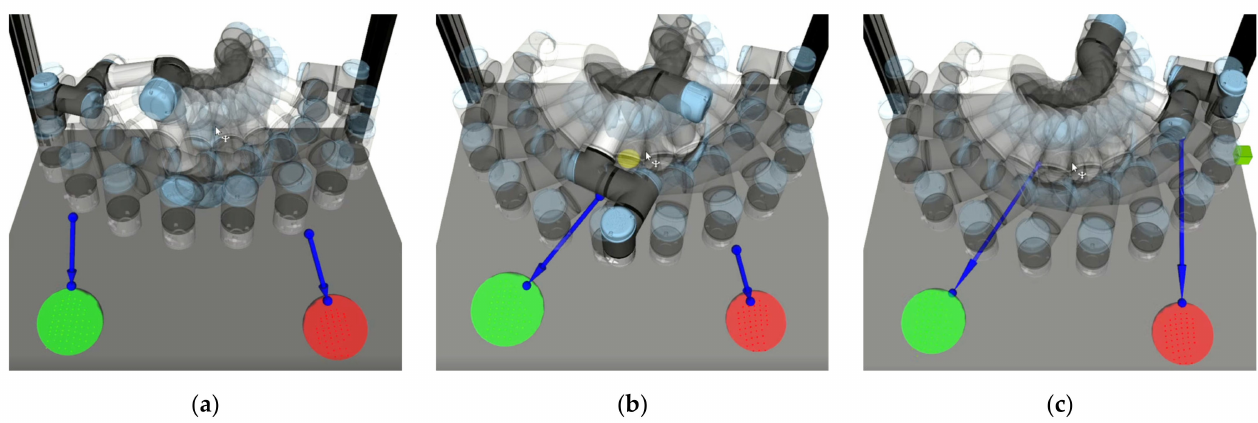
Figure 11. Example of how collision vector changes during a motion sequence: robot moving from left to the right ( a – c ), collision vector is depicted by a blue arrow, HMIs are represented by green and red